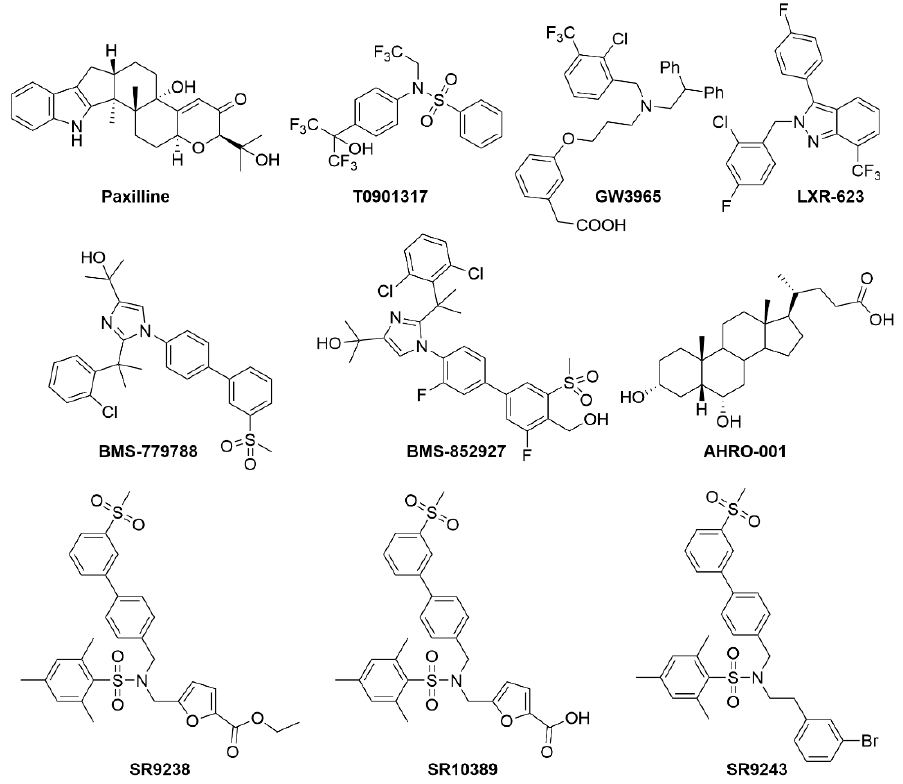
Figure 8. Known LXR modulators.